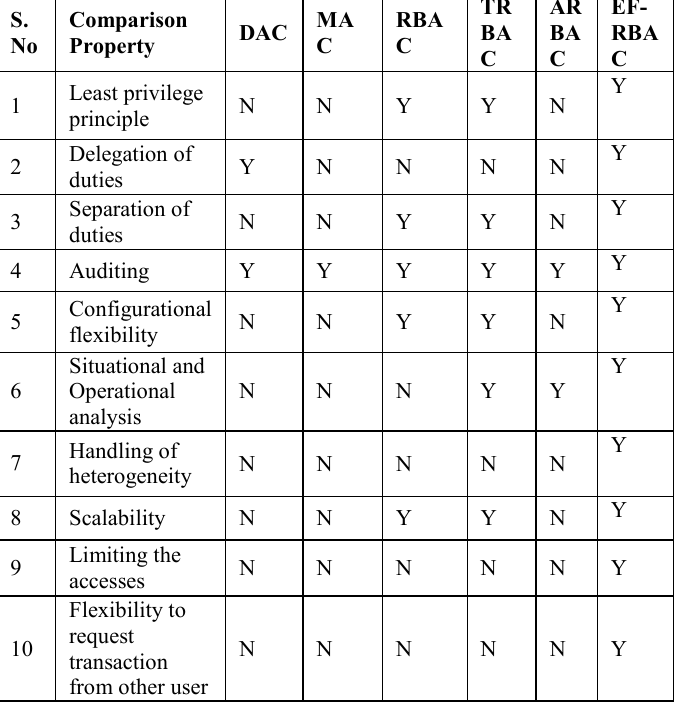
Table 2. EF-RBAC against ordinary methods of